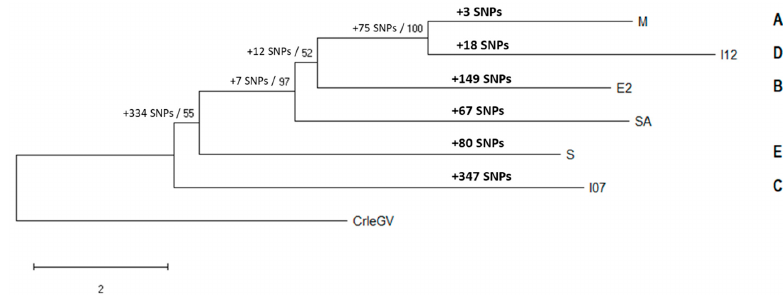
Figure 1. CpGV phylogeny based on complete genome sequences for isolates from groups A-E and CpGV-SA. The number of unique SNPs present in each isolate is shown above the branches in bold. The number of SNPs per grouping is shown at each node alongside the bootstrap values. CpGV groups are indicated to right of the respective